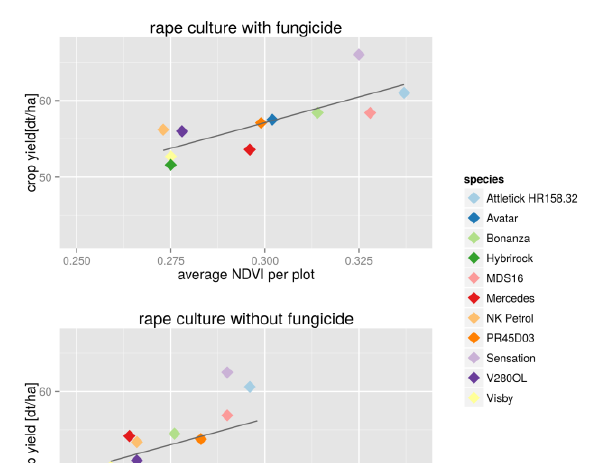
Figure 10. NDVI map of rape test plots (MultiSpec 4C, GSD 10 cm, 16.07.2014)